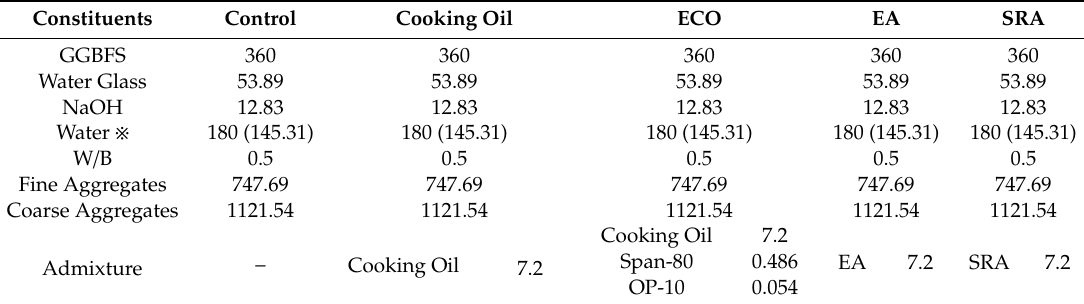
Table 5. Concrete mixture proportion (kg / m 3